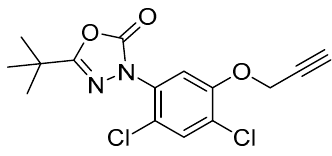
Figure 1. Chemical structure of oxadiargyl.